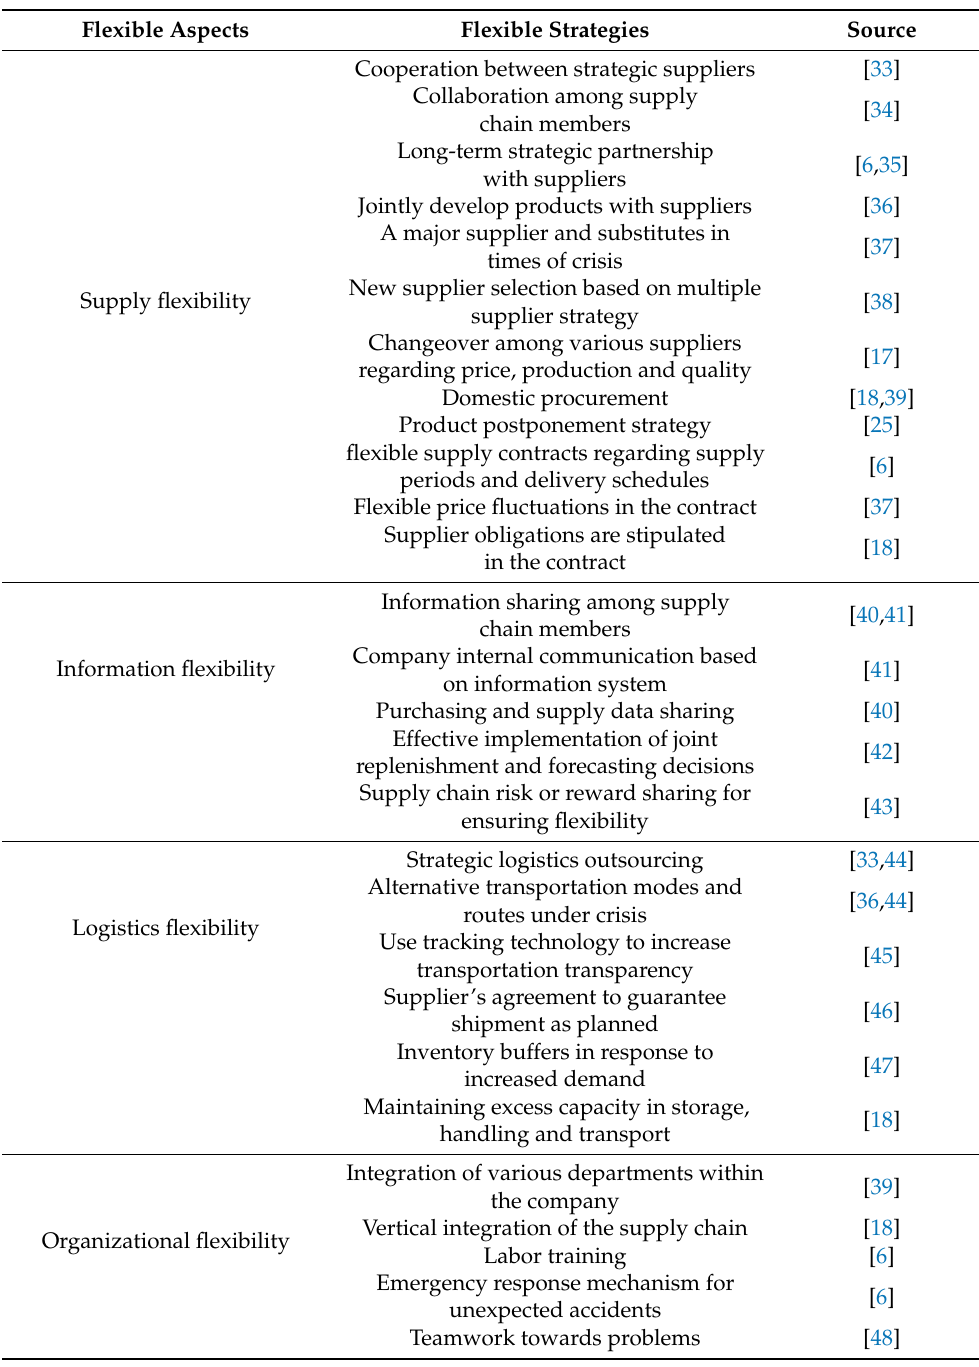
Table 1. Flexible strategies of supply